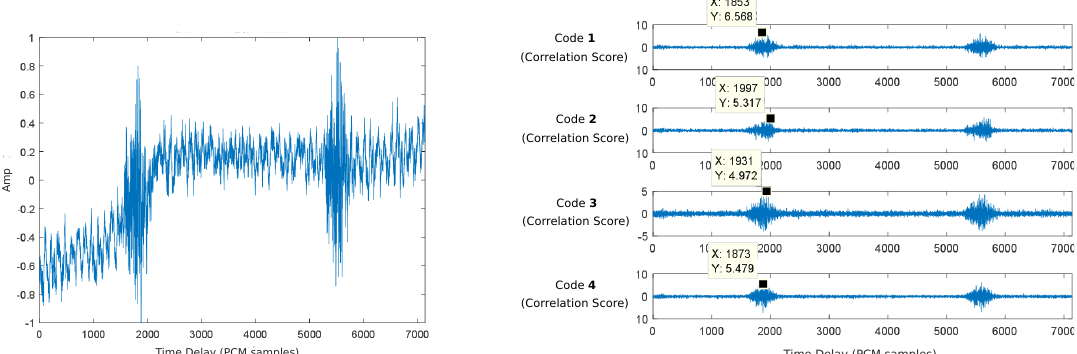
Figure 13. Relative positions extracted from the cross-correlation of the acquired signal with the four Kasami